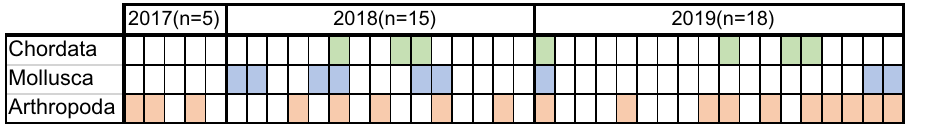
Table 1. Presence (coloured) or absence (white) of freshwater organisms (at the order level) in the fecal samples of Japanese macaques collected near the Azusa River in Kamikochi (Chubu Sangaku National Park), Japan.